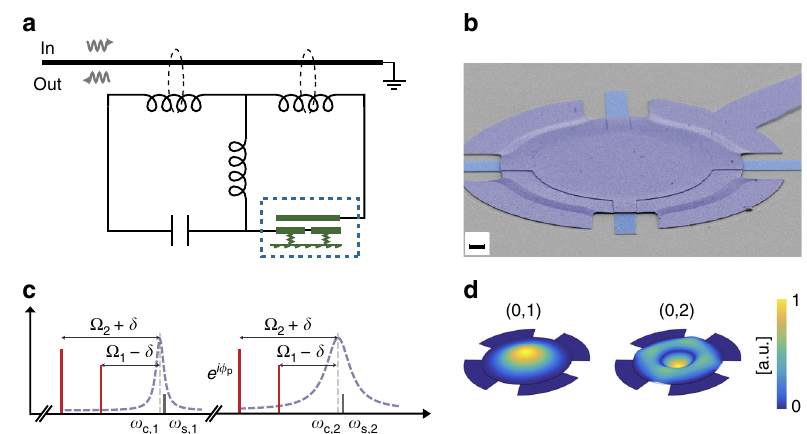
Fig. 2 Implementation of a superconducting microwave circuit optomechanical device for nonreciprocity. a A superconducting circuit featuring two electromagnetic modes in the microwave domain is capacitively coupled to a mechanical element (a vacuum-gap capacitor, dashed rectangle ) and inductively coupled to a microstrip feedline. The end of the feedline is grounded and the circuit is measured in re fl ection. b Scanning electron micrograph of the drum-head-type vacuum gap capacitor ( dashed rectangle in a ) with a gap distance below 50 nm, made from aluminium on a sapphire substrate. The scale bar indicates 2 μ m. c Frequency domain schematic of the microwave pump setup to achieve nonreciprocal mode conversion. Microwave pumps ( red bars ) are placed at the lower motional sidebands — corresponding to the two mechanical modes — of both microwave resonances ( dashed purple lines ). The pumps are detuned from the exact sideband condition by ± δ = 2 π ⋅ 18 kHz, creating two optomechanically induced transparency windows detuned by 2 δ from the microwave resonance frequencies (denoted by ω c,1 and ω c,2 , vertical dashed lines ). The phase ϕ p of one the pumps is tuned. The propagation of an incoming signal (with frequency ω s,1 or ω s,2 , solid grey bars ) in the forward and backward direction depends on this phase and nonreciprocal microwave transmission can be achieved. d Finite-element simulation of the displacement of the fundamental (0, 1) and second order radially symmetric (0, 2) mechanical modes (with measured resonant frequencies Ω 1 /2 π = 6.5 MHz and Ω 2 /2 π = 10.9 MHz, respectively) which are exploited as intermediary dissipative modes to achieve nonreciprocal microwave